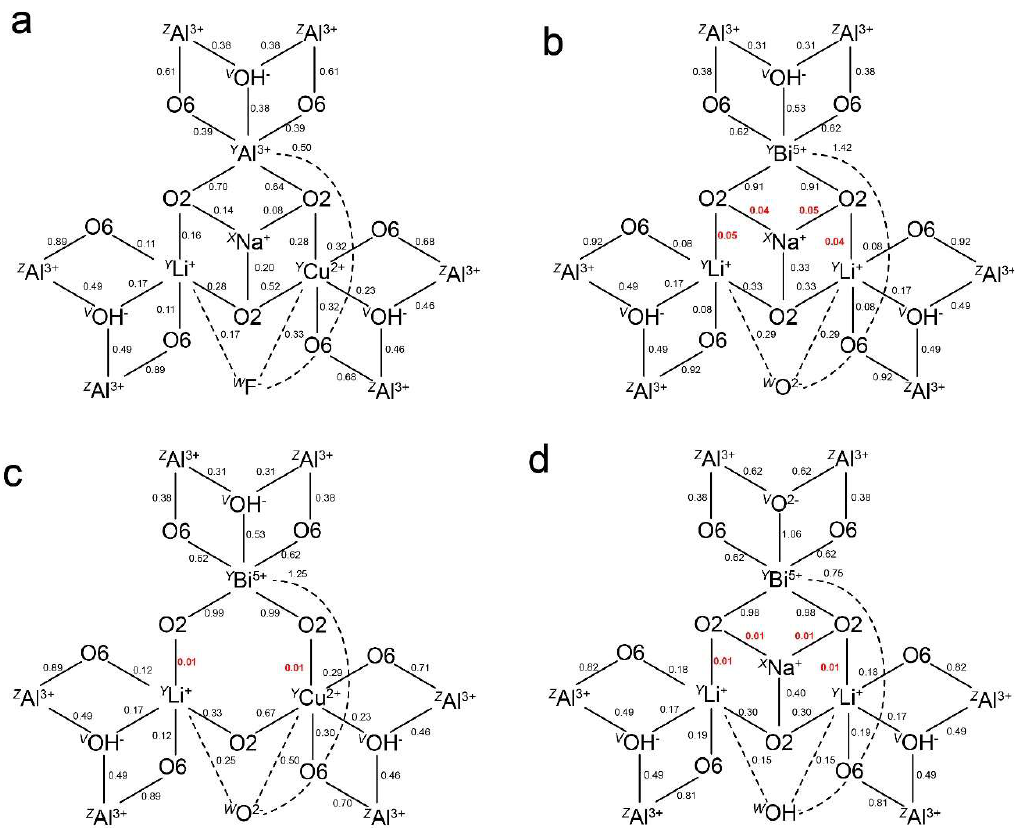
Figure 11. Structural arrangement graphs of the Y-site neighborhood in the structure of ( a ) Cu-bearing elbaite and arrangements derived from it by ( b ) Bi 5 + Li 1 + W O 2 − (Al 3 + Cu 2 + W F − ) − 1 , ( c ) Bi 5 + (cid:3) W O 2 − (Al 3 + Na 1 + W F − ) − 1 , ( d ) Bi 5 + Li 1 + V O 2– W OH − (Al 3 + Cu 2 + V OH – W F − ) − 1 substitutions. The values in red color indicate bond valences, which do not seem to be